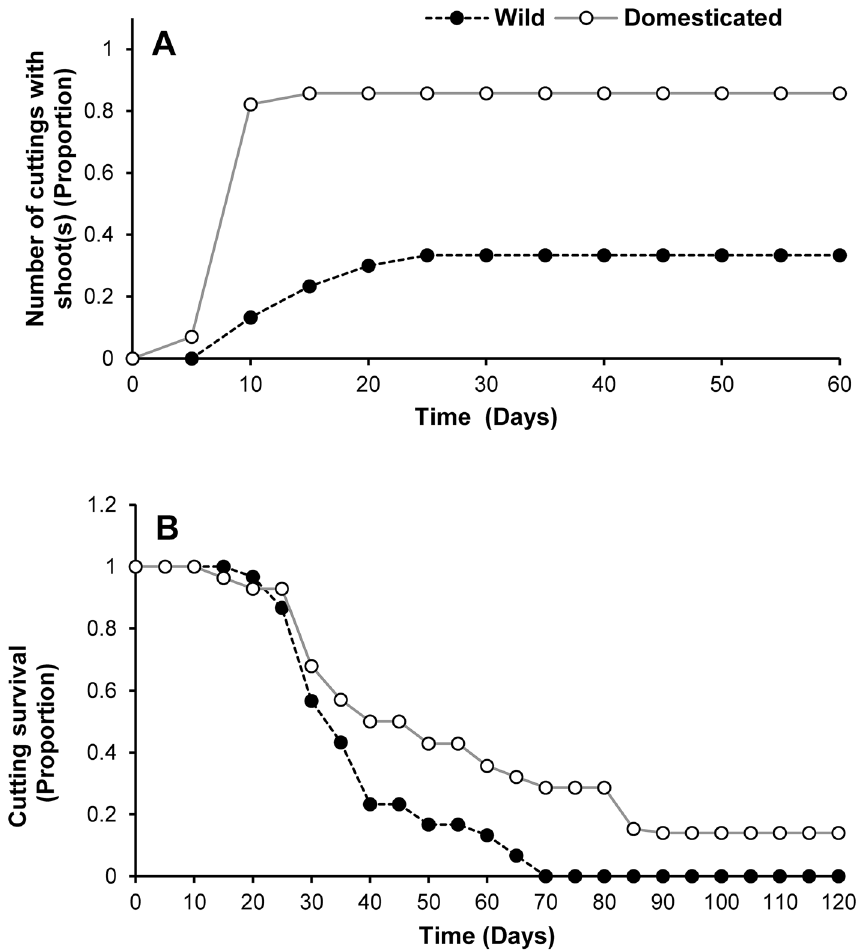
C. aconitifolius after 120 days of monitoring under controlled environmental conditions ( B